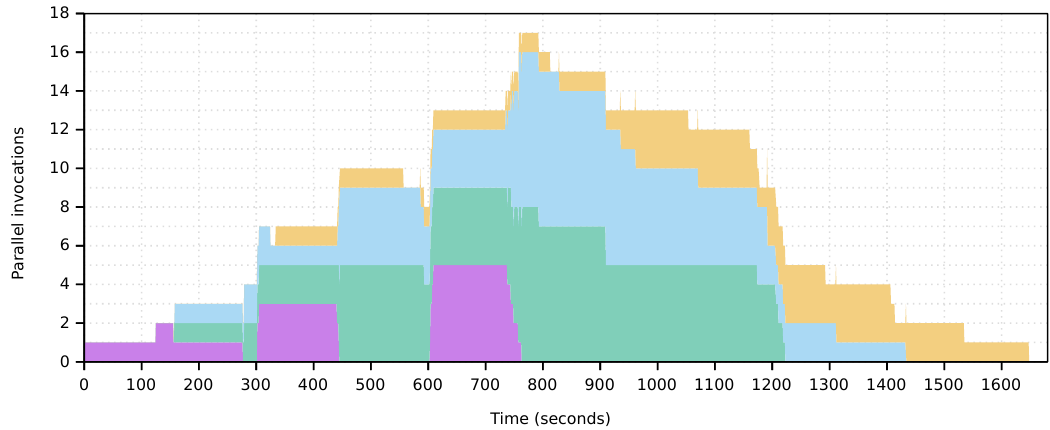
Figure 8. Time chart for the processing of ten videos using the workflow. Parallel invocations of the functions appear stacked. For the YOLOv3 function (running on AWS Batch) the pending and running states are